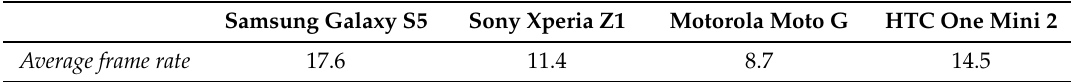
Table 2. Frame rate comparison using offline processing of a recorded sequence.